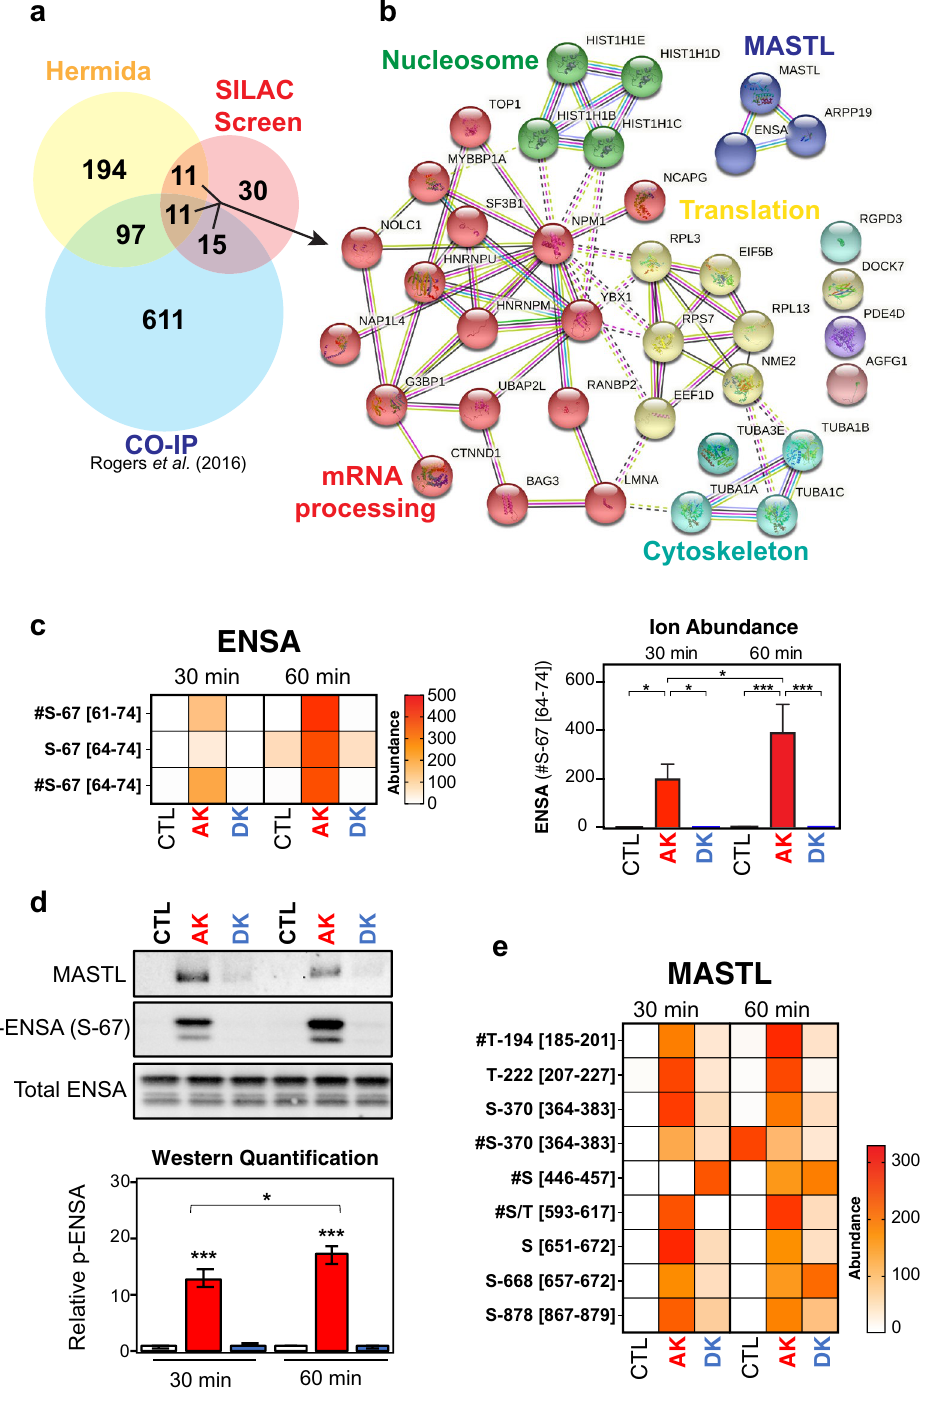
Figure 3. In vitro kinase assay validation of ENSA phosphorylation by MASTL. (a) Venn diagram comparing previously identified MASTL interacting proteins by co-immunoprecipitation 55 with those identified from A, and (b) subsequent STRING cluster analysis 49 of common proteins. (c) The abundance of each ENSA phospho-site activated in reactions between MASTL kinase and ENSA. The ion abundance for the #Ser67 [64–71] phospho-peptide is normalized to the 60 min control (CTL) reaction. Error bars display the standard error of the mean from three independent reactions. Square brackets indicate peptide locations within the protein on which each phospho-site was found. Hashtags denote a co-modification within that peptide, e.g., carbamidomethylation, deamidation, and/or oxidation (detailed in Supplementary Table S6). (d) Western blot confirmation of ENSA phosphorylation at S-67 in the presence of active MASTL kinase. Total ENSA was used as the loading control and normalization factor for densitometry analysis. P-ENSA/Total was further normalized to the 60 min control (CTL) reaction. Error bars display the standard error of the mean from three independent reactions. (e) The abundance of MASTL phospho-sites present in reactions with ENSA are represented here as a heat map. Two reaction conditions were tested (60 min incubation in presence of 0.5 mM ATP or 1 mM ATP). Phospho-site abundances were calculated using label- free